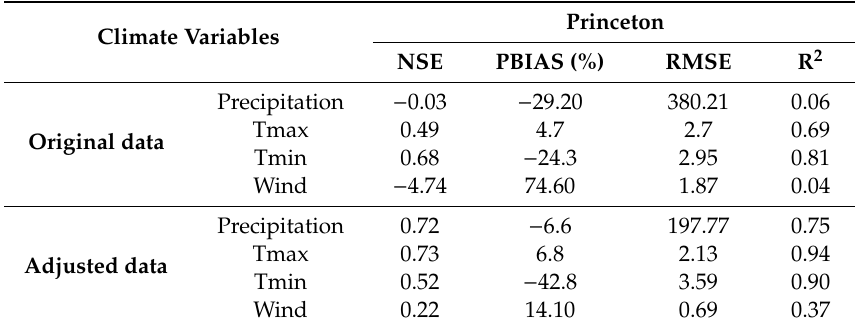
Table 3. Statistical comparisons of Nash–Sutcliffe efficiency (NSE), percent bias (PBIAS), root ‐ mean ‐ square error (RMSE), and correlation coefficient (R 2 ) for average annual precipitation, maximum and minimum temperatures, and wind speed between gridded data and observations at the 37 station points before (original) and after the adjustment (adjusted).